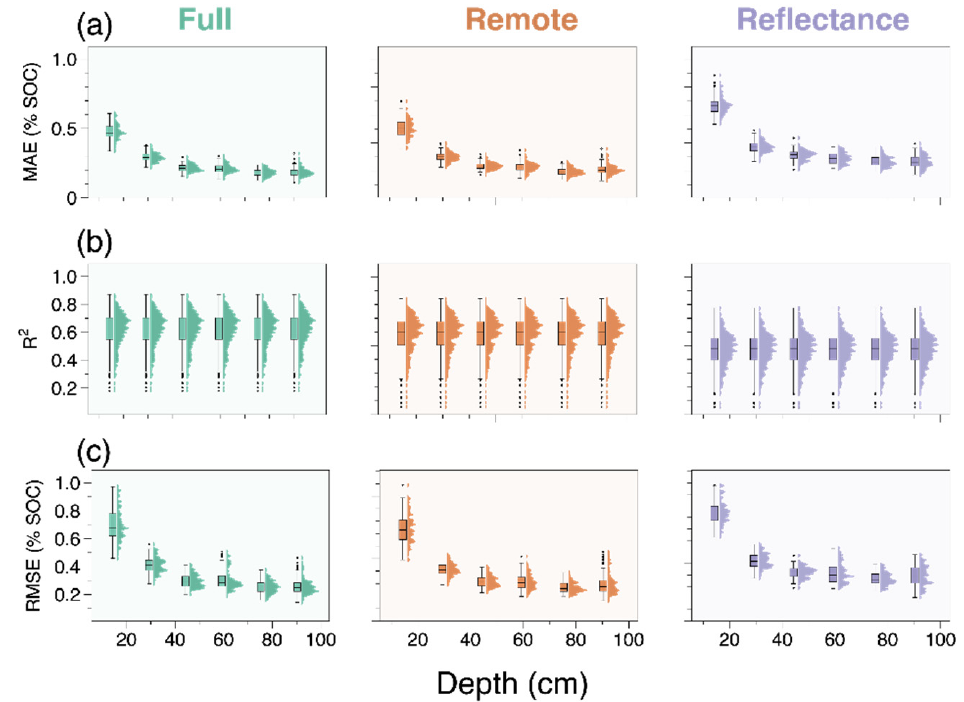
Figure 5. Model performance measured as Mean Absolute Error (MAE) ( a ), coefficient of determination (R 2 ) ( b ), and Root Mean Square Error (RMSE) ( c ) of different model types across depth increments measured ( n = 1738). Raincloud plots adjacent (right) to each boxplot depict the histogram of raw data points and the frequency of different binned observations. Model bars in each boxplot represent the median value of 100 train/test splits for the corresponding model by depth combination; outer edges of the boxes represent the 25 and 75% percentiles; whiskers represent 1.5 × the interquartile range, and points represent outlying values greater than 1.5 × the interquartile range. Data are from soils collected from nineteen participating ranches encompassing approximately 17,347 ha in the Southern Great Plains ecoregion of the United States. Table 2. Metrics of model accuracy and bias for Reflectance, Remote, and Full model types devel- oped, including Mean Absolute Error (MAE), coefficient of determination (R 2 ), and Root Mean Squared Error (RMSE). Numbers represent the mean and standard deviation in parentheses of each metric for 100 randomly selected test datasets from soils ( n = 1738) collected from nineteen partici- pating ranches encompassing approximately 17,347 ha in the Southern Great Plains ecoregion of the United States. Model Type